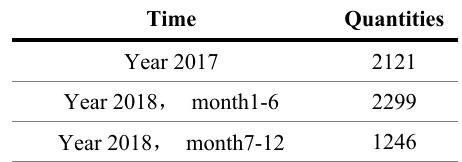
Table 3. Image storage statistics